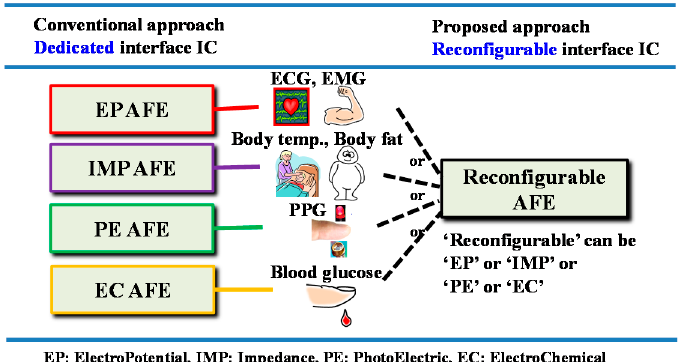
Figure 1. Difference between the conventional and proposed approaches.